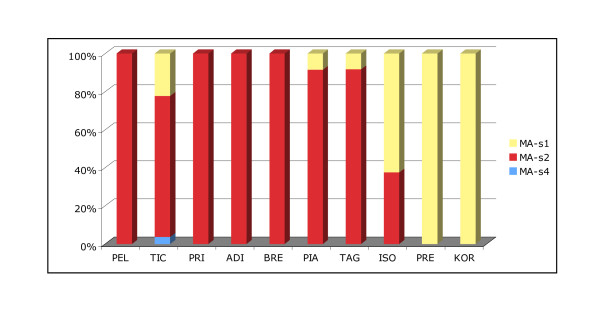
Frequency of marble trout haplotypes (MA-s1, MA-s2 and MA-s4) across samples, labelled as in Figure 1.